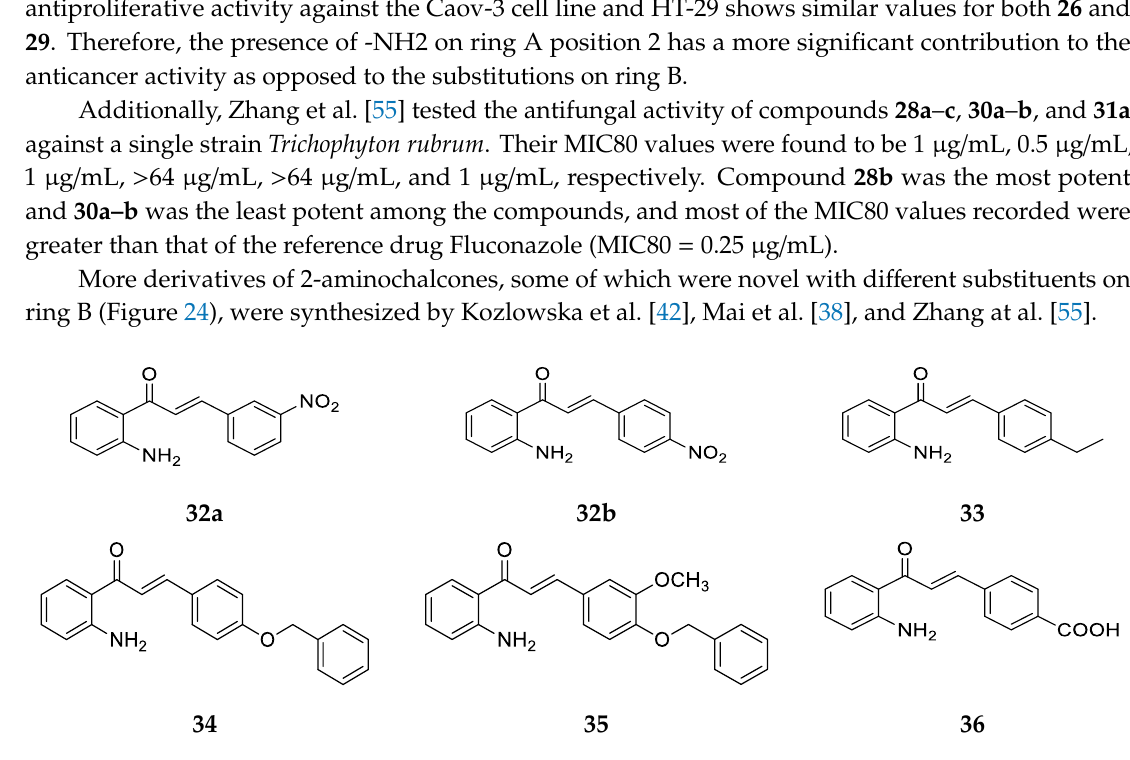
Figure 24. Chemical structures of derivatives of 2-aminochalcone with substitution on ring B.